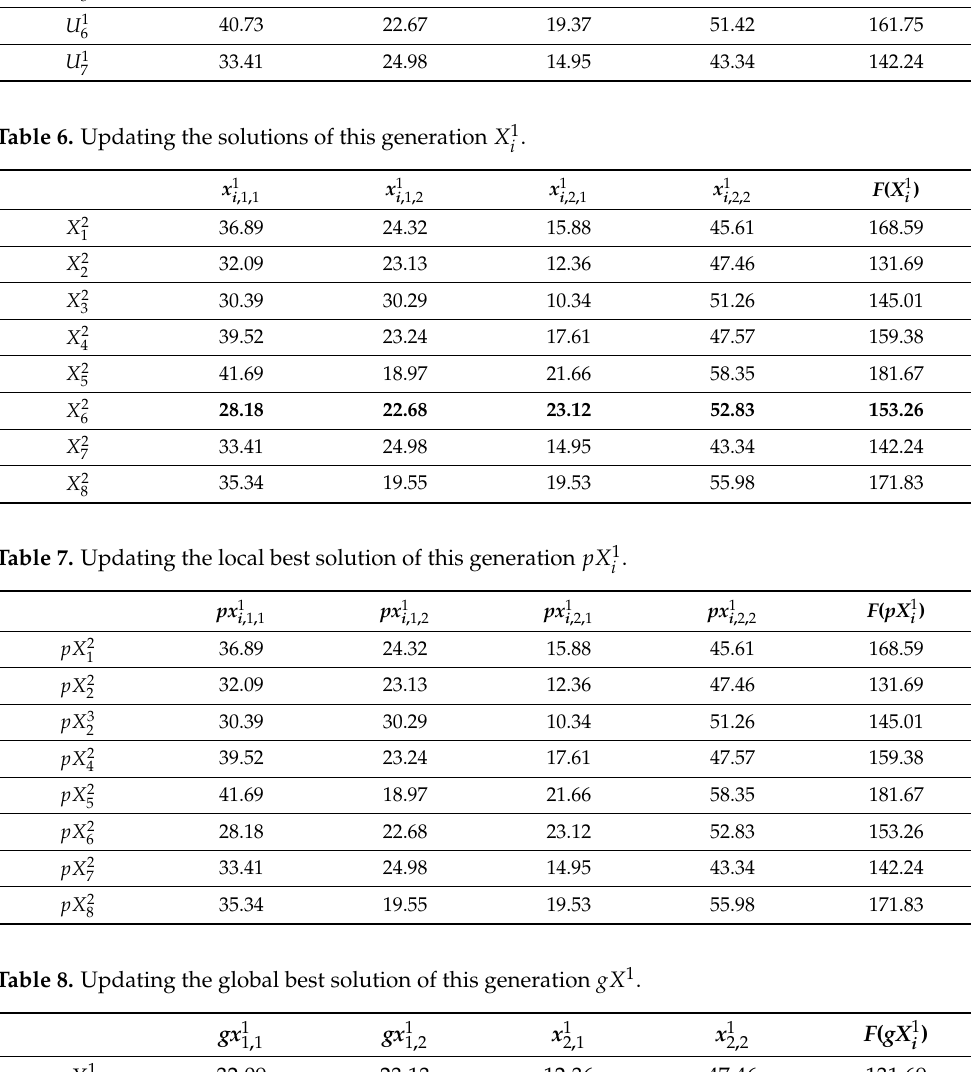
Table 5. Generating mating solution U 1